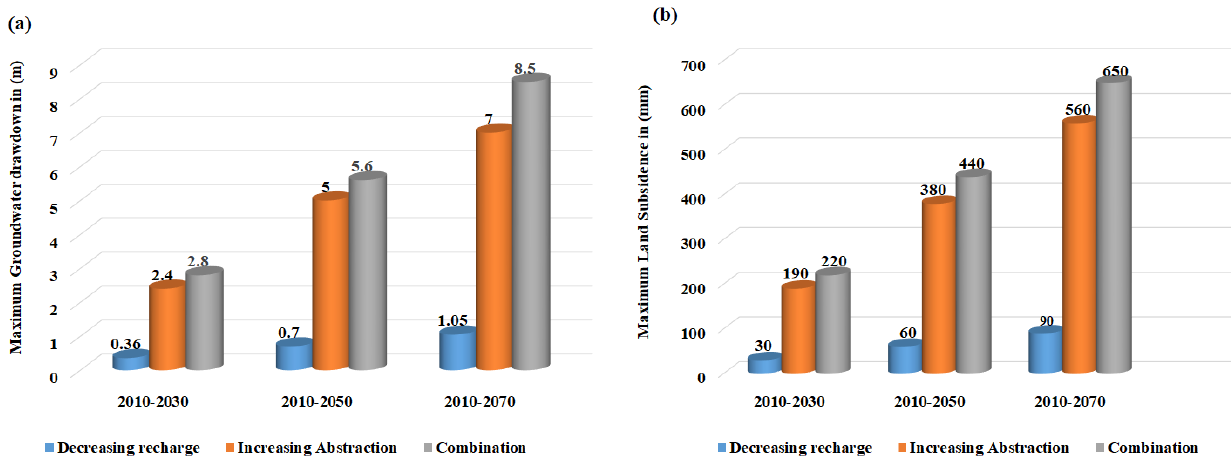
Figure 11. Comparison between the results of different scenarios ( a ) Maximum drawdown in (m) for different scenarios, ( b ) maximum land subsidence in (mm) for different scenarios .